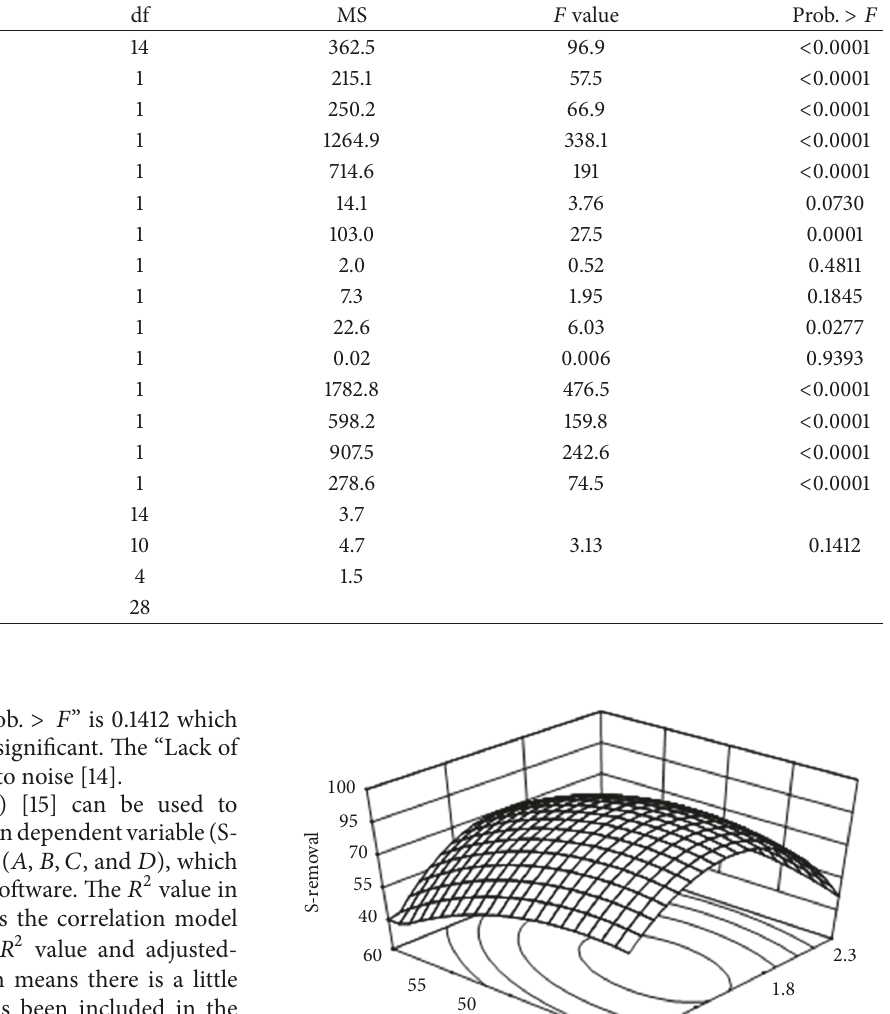
Table 3: Analysis of variance (ANOVA) for response surface quadratic model.